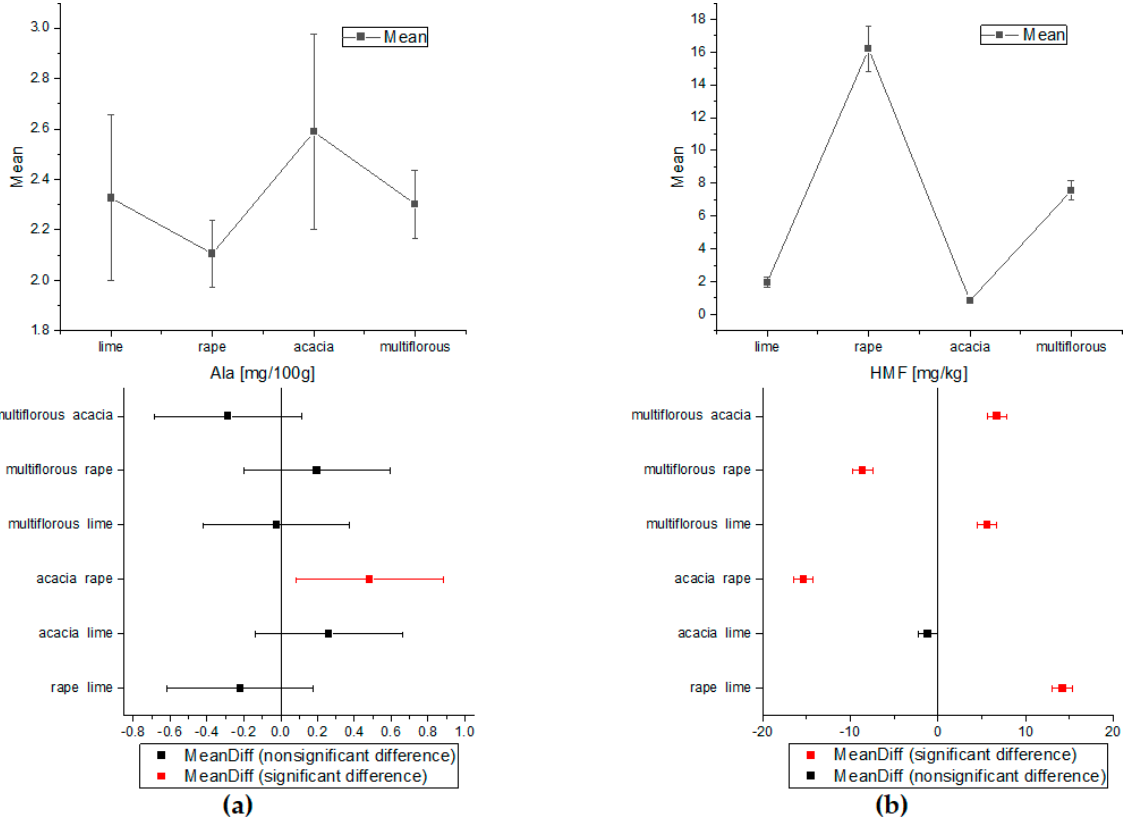
Figure 4. The comparison of the average content of Ala and HMF obtained by ANOVA ( a ) for alanine and ( b ) for HMF (Tukey test, p < 0.05).